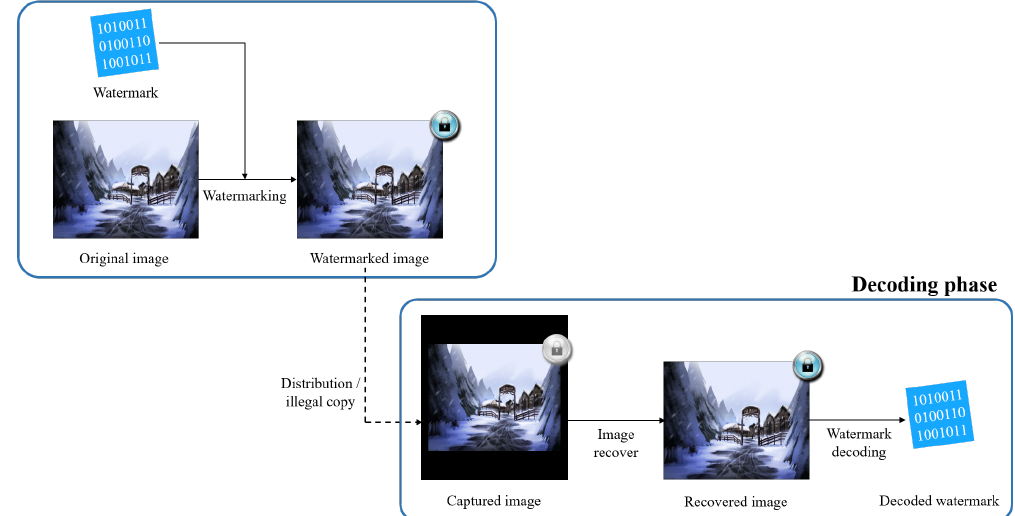
Figure 1. Illegal distribution scenario for real-time web-comics and watermark extraction process suitable for this scenario. Illegal distribution is frequently caused by screen capturing on Internet browsers and smartphone applications. Scaling and translation occur in this process and these distortions must be corrected before watermark